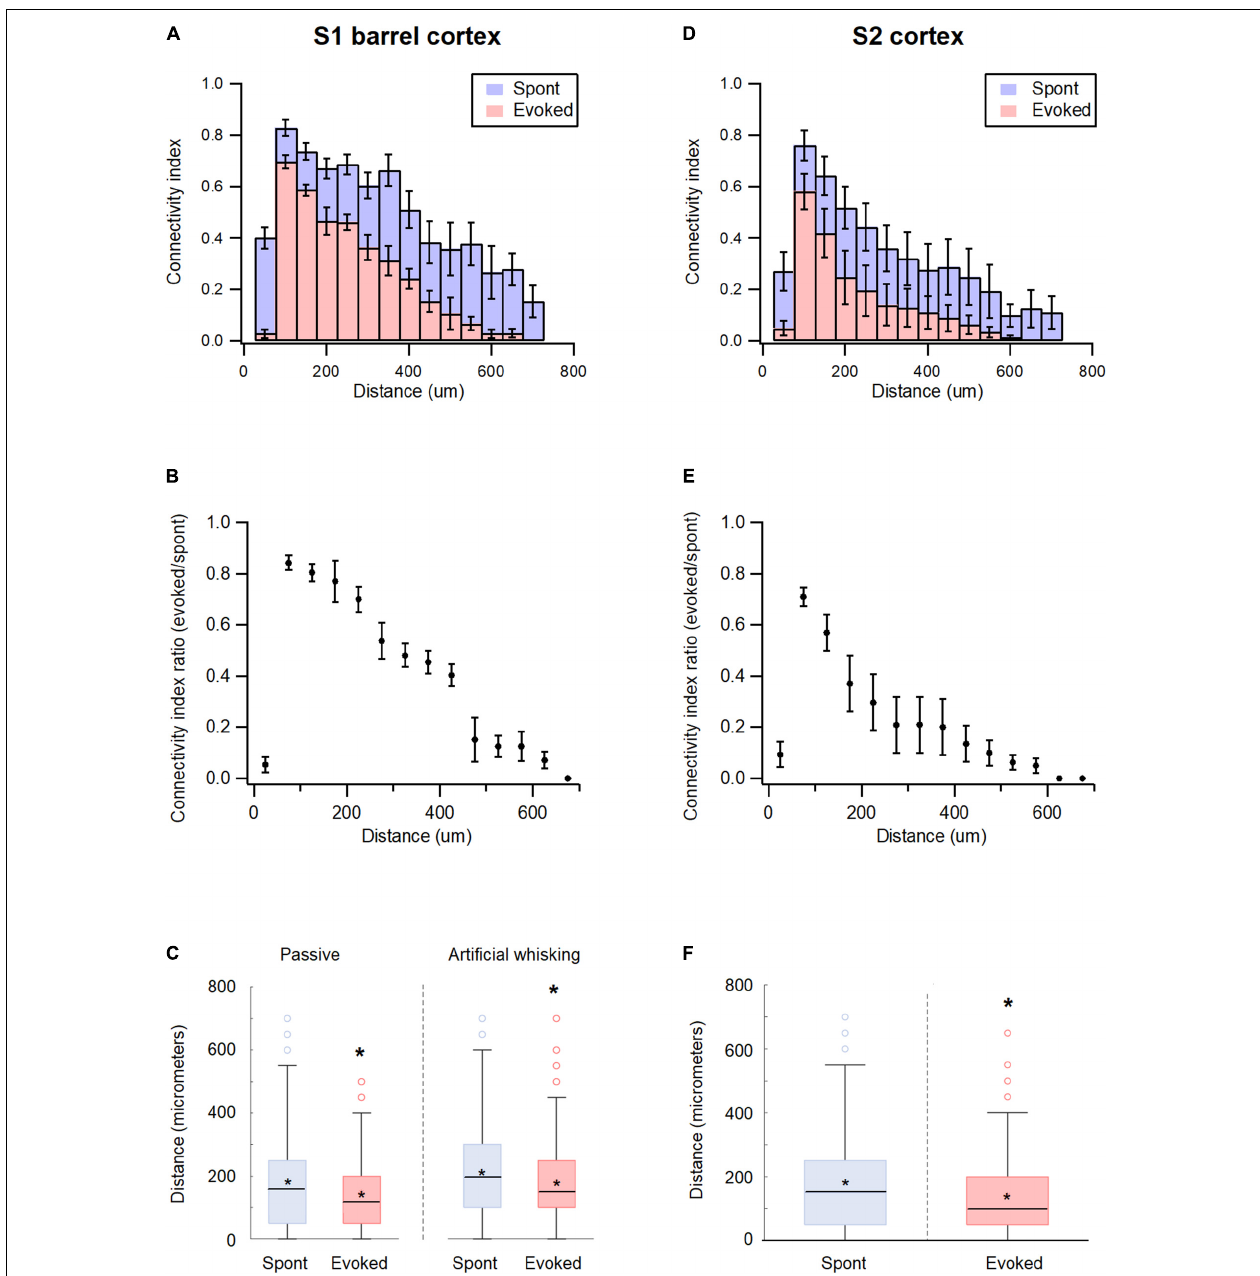
FIGURE 6 | Distance dependency of functional connectivity in somatosensory cortices according to distance. (A,D) Histograms of the average connectivity index ( M ± SEM ) at different distance values between the recorded neuron pairs during spontaneous (blue) and evoked (red) activity states in wS1 (A) and wS2 (D) cortices. (B,E) Average ( M ± SEM ) ratio of connectivity index between the evoked and spontaneous activity states in wS1 (B) and wS2 (E) cortices. (C) Box plots of the distance between connected units in wS1 during the spontaneous (blue) and evoked (red) activity states for ramp-and-hold (passive) and artificial whisking against sandpaper (artificial whisking) whisker activation paradigms. The middle line in the boxplots represents the median value and the asterixis represents the mean value. A value of p < 0.05 was obtained with the t -test. (F) Box plots of the distance between connected units in wS2 during the spontaneous (blue) and evoked artificial whisking (red) mediated activity states. The middle line in the boxplots represents the median value and the asterixis represents the mean value. A value of * p < 0.05 was obtained with the t -test.